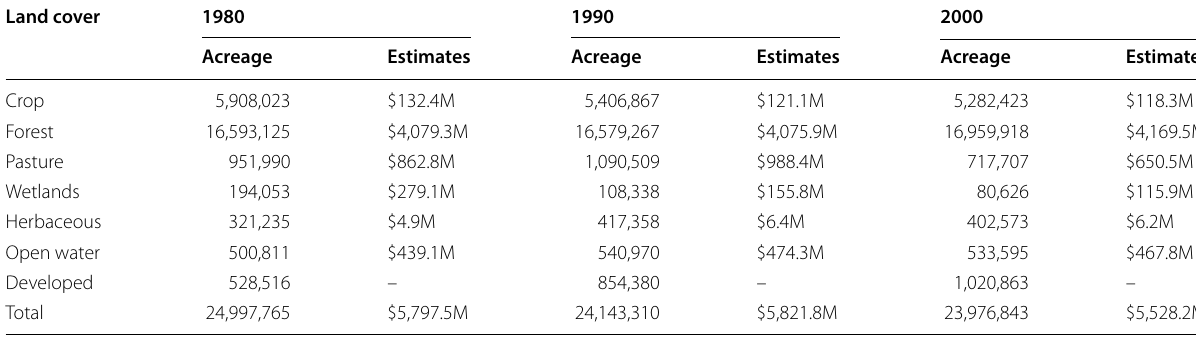
Table 4 Pervious covers and opportunity costs change since 1980 through 2000 Land